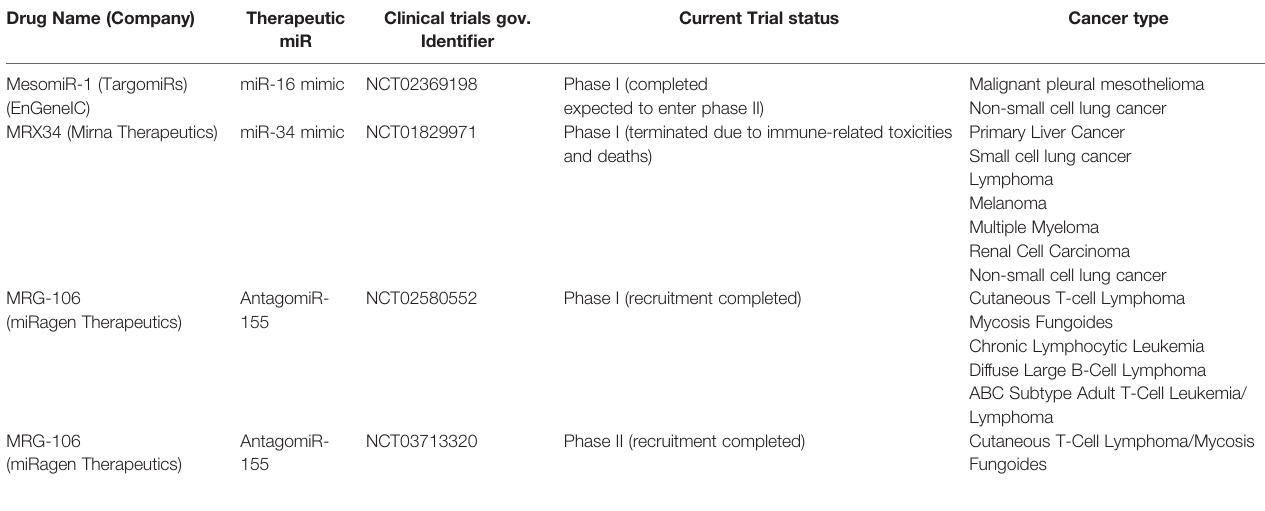
TABLE 3 | Clinical trials of miR-therapeutics in human